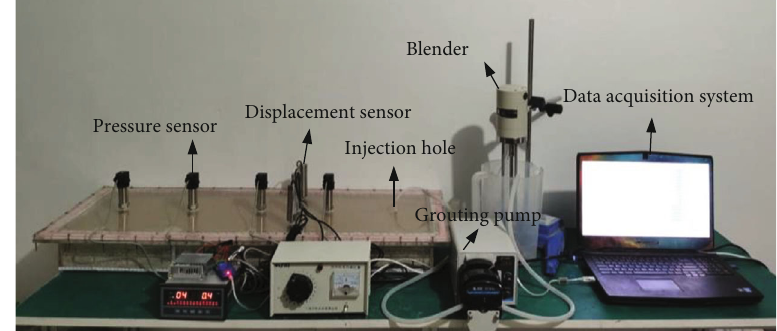
Figure 3: Experimental system.